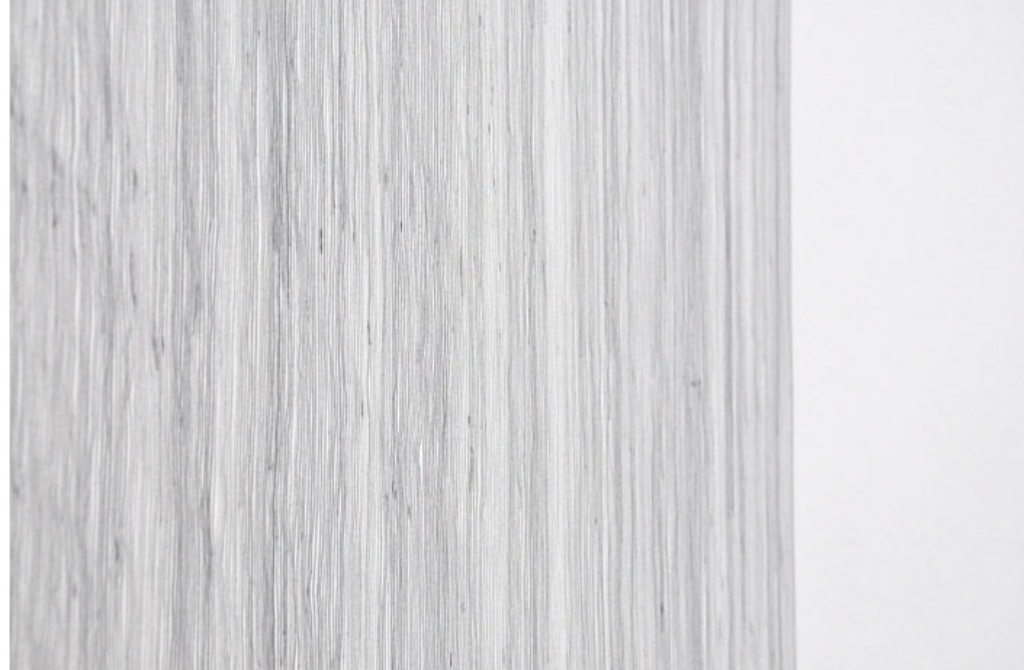
Figure 9. A line that, in theory, could connect us , 2016. Studio experiment detail. Pencil on paper. Collection of the artist.